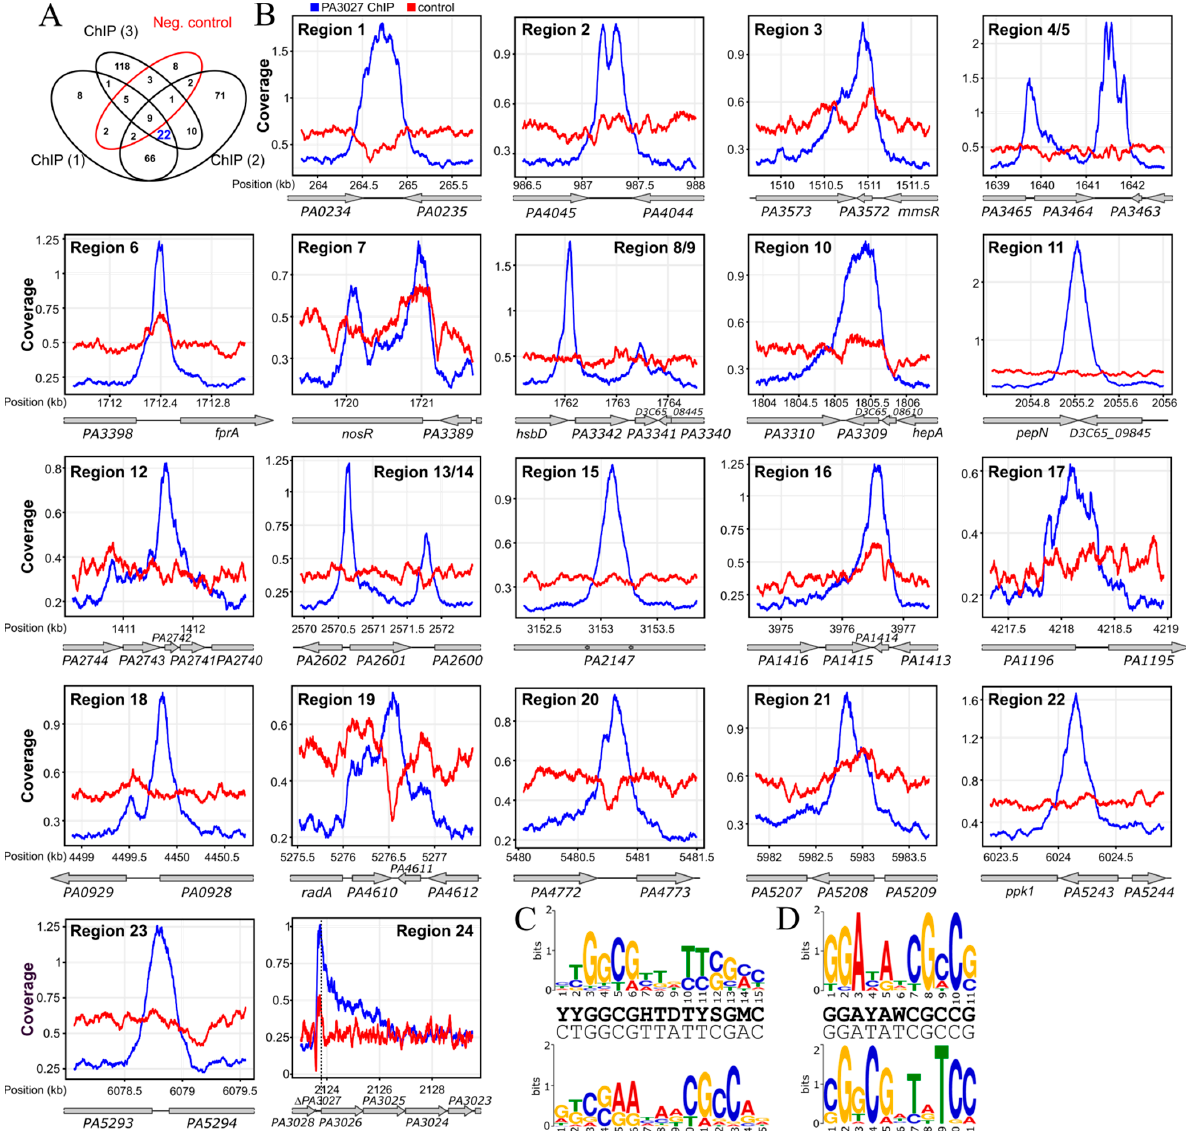
Figure 3. PA3027 binding sites in P. aeruginosa genome. ( A ) Venn diagram for ChIP-seq peaks obtained for samples of FLAG-PA3027 overproducing cells (F–PA3027+) and negative control (F–EV+). ( B ) ChIP-seq signal over regions encompassing PA3027 binding sites. The plots show coverage with reads for indicated positions in the PAO1161 genome (kb), normalized per genome coverage (RPGC), and averaged for ChIP replicates. Genes are presented as grey arrows, only names of PAO1 orthologs are shown for clarity. ( C , D ) The consensus sequence logos of predicted PA3027 binding sites, obtained by MEME software [44,45] using 200 bp around 24 PA3027 peak summits ( A ) as well as the same 24 PA3027 peak summit regions with an extended to 500 bp 24 region encompassing PA3026 upstream sequences ( B ). The height of an individual letter represents the relative frequency of that nucleotide at that position. The consensus sequence (up line) and the most common nucleotide at each position (down line) are presented for each motif. The reverse complement presentation of sequence logos are shown below.